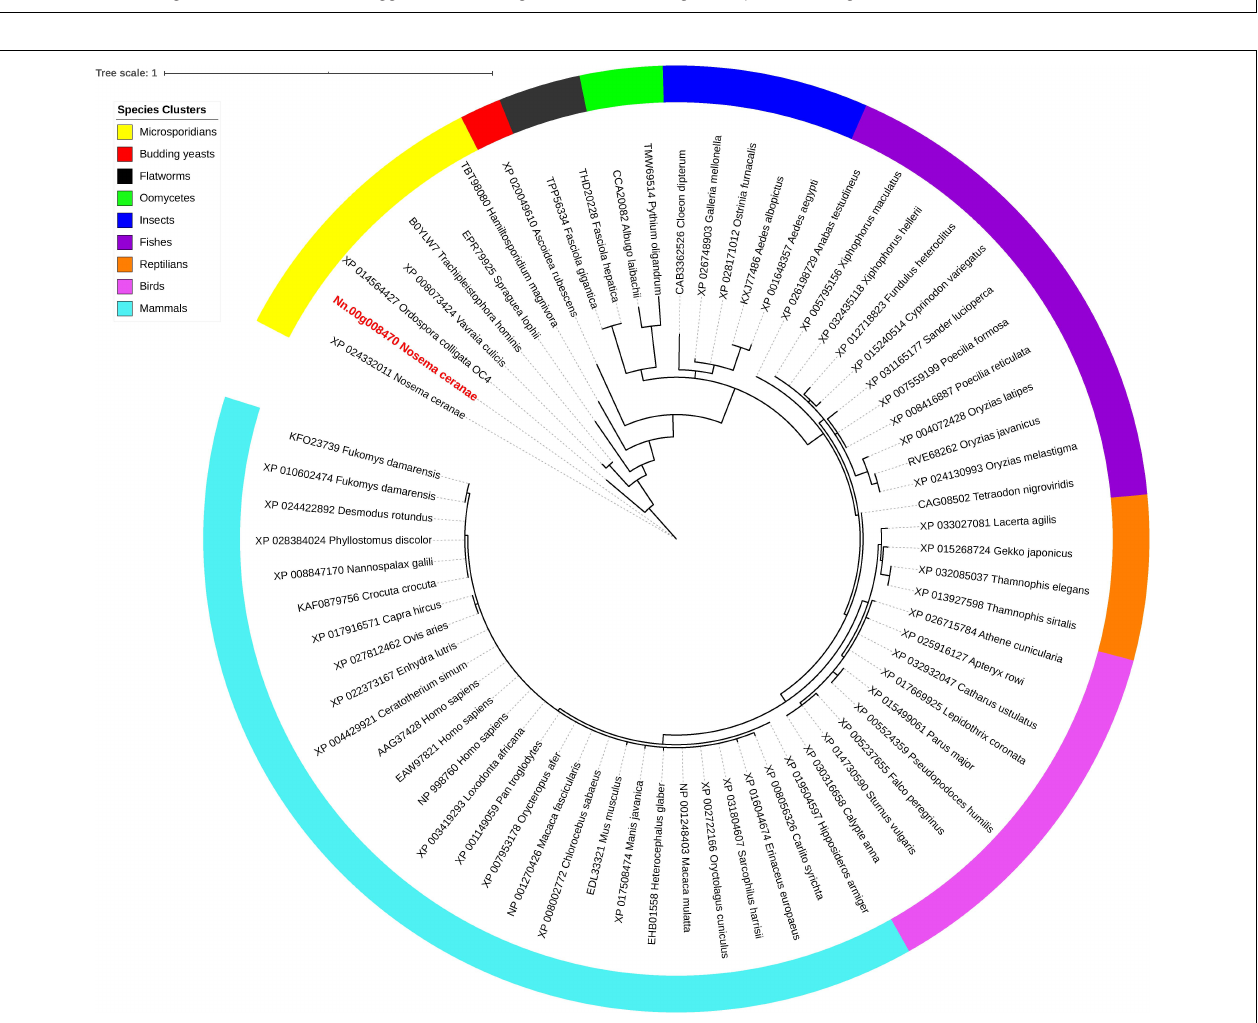
FIGURE 4 | Phylogenetic trees of the gene Dicer and surrounding regions. (A) The tree was constructed based on the protein sequences of the gene Dicer . M. daphniae was used to root the tree. (B) The tree was constructed based on the nucleotides up and down stream of the gene Dicer . N. bombycis was selected to root the tree. The congruence of the two trees suggests a hitchhiking effect of Dicer during microsporidian divergence.